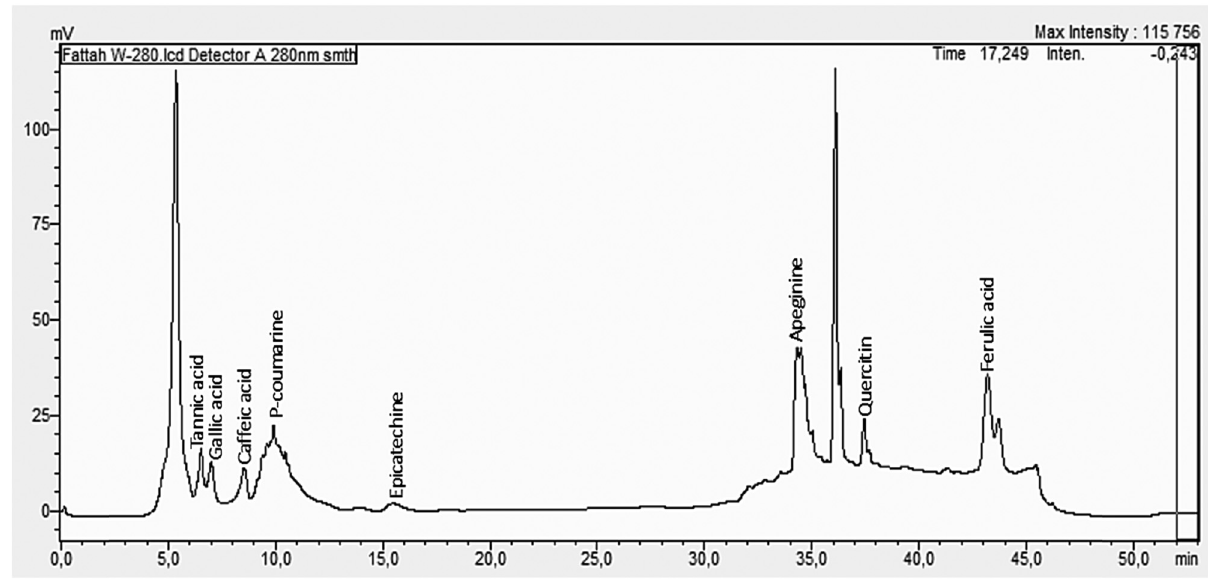
Figure 3: HPLC chromatographic pro fi le of W. frutescens